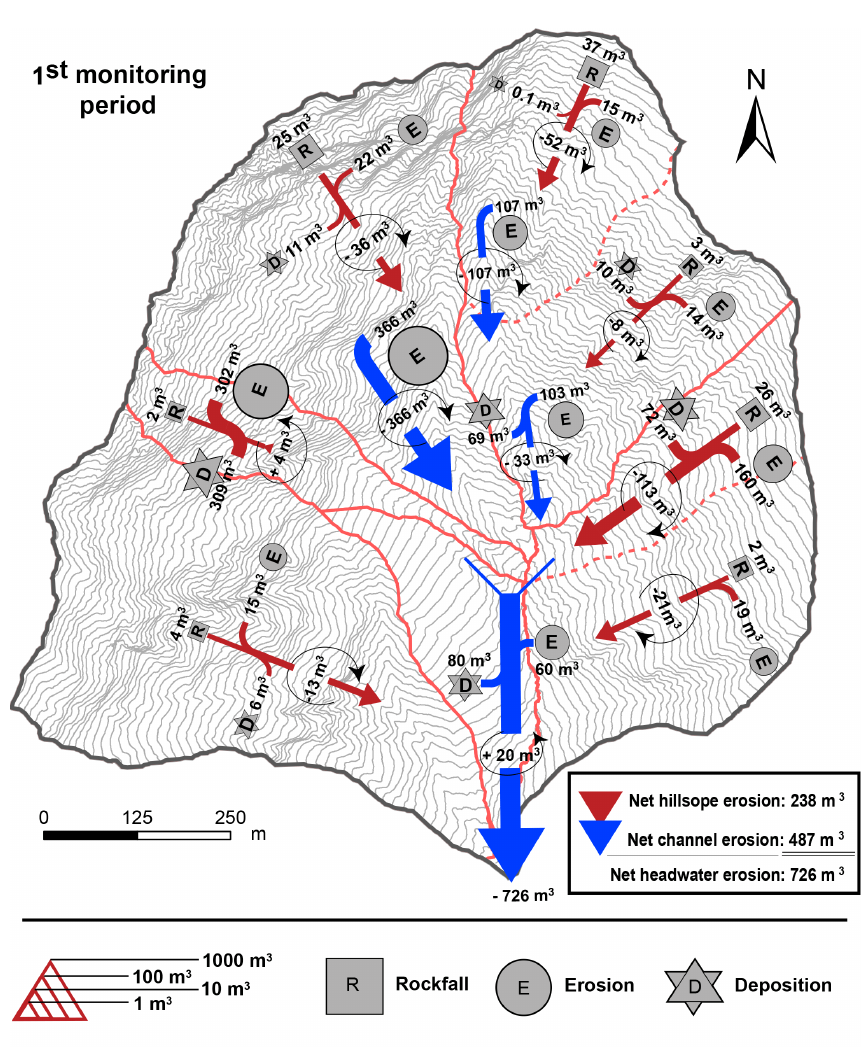
Figure 13. Overall headwater sediment budget observed during the first monitoring period revealing the sediment dynamics through the spring–summer season and the net balance of sediment recharge in the downstream torrent for several months preceding the August 2009 debris